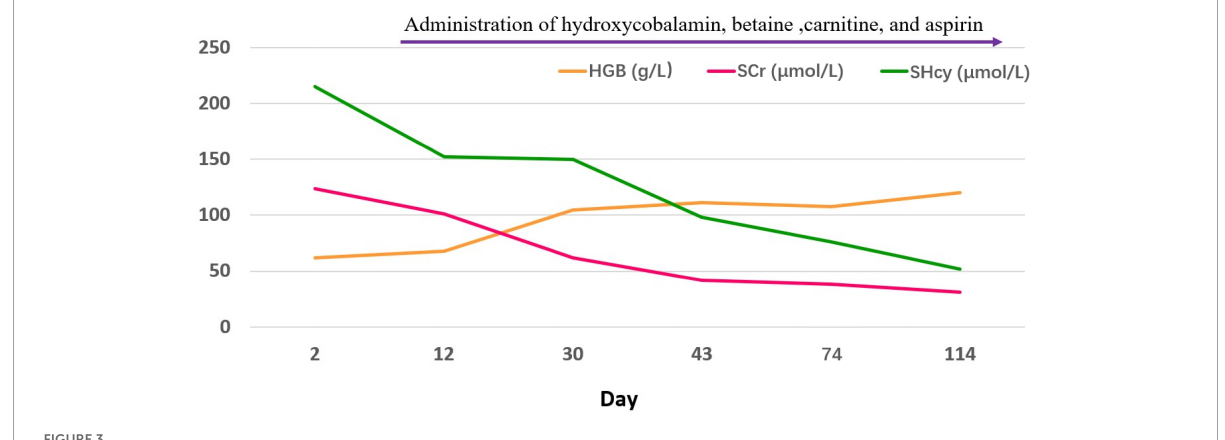
FIGURE3 The changes of hemoglobin, serum creatinine, and serum homocysteine.